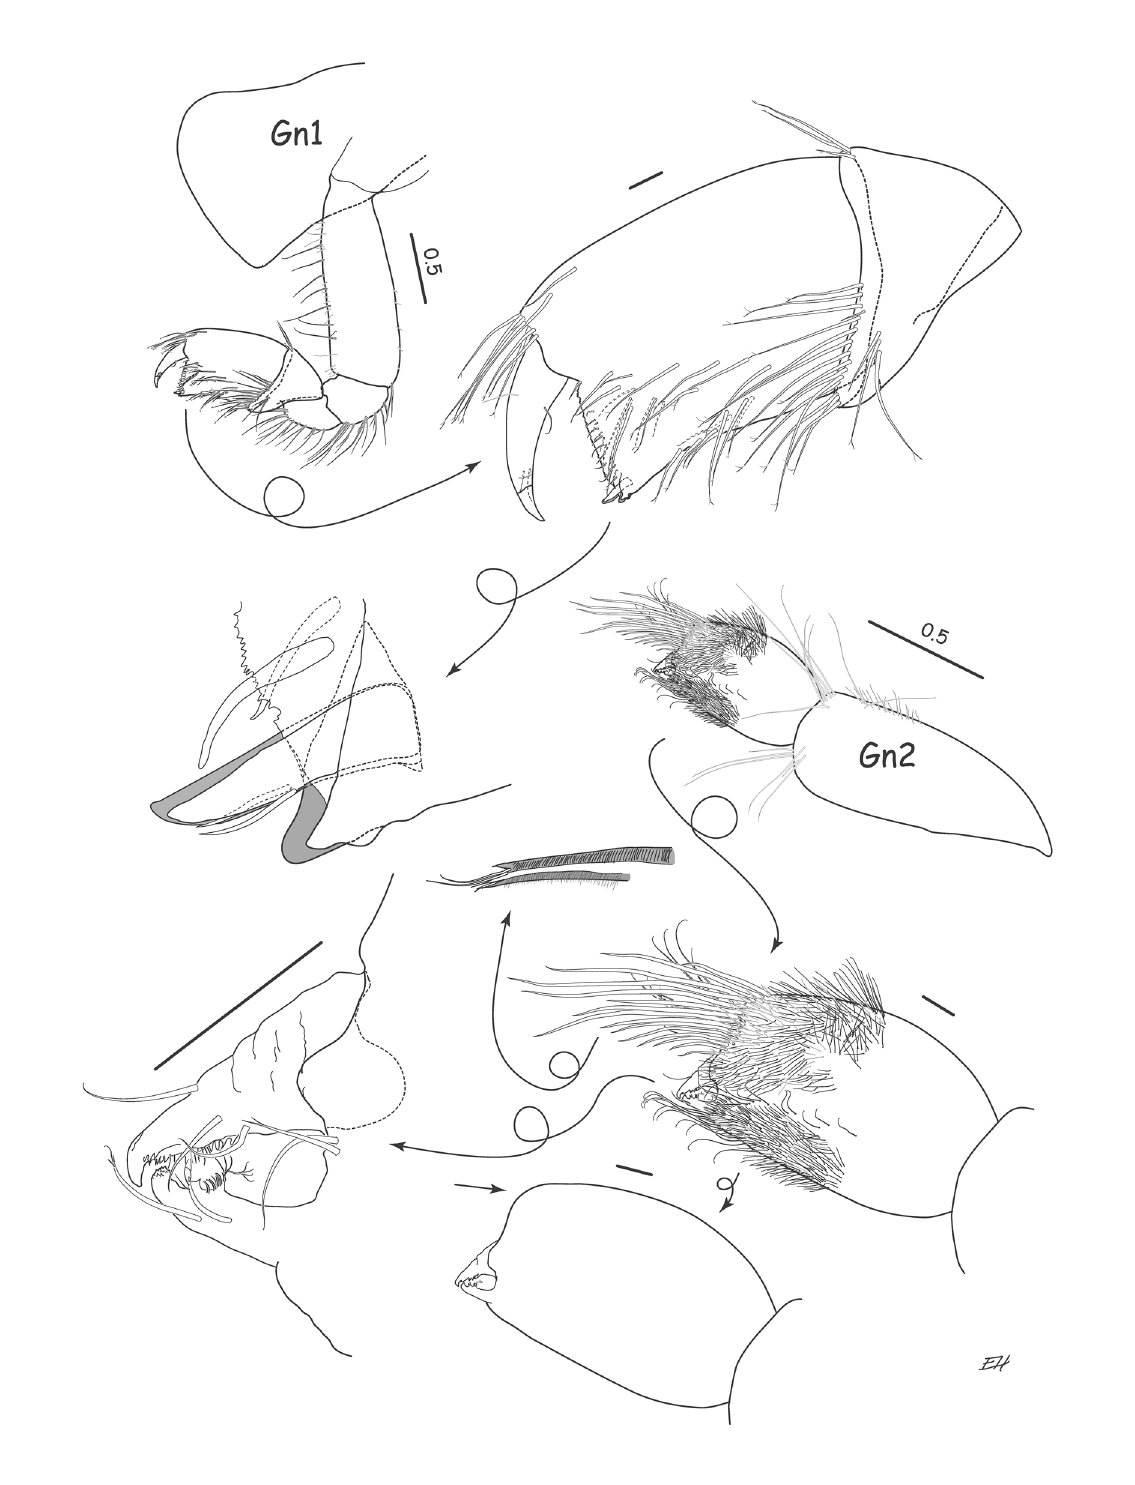
Fig. 31. Abyssorchomene shannonae sp. nov., holotype, ♀, 12 mm (ZMH K-61209). Setae omitted on Gn2 propodus outline. Scale bars = 0.1 mm unless indicated